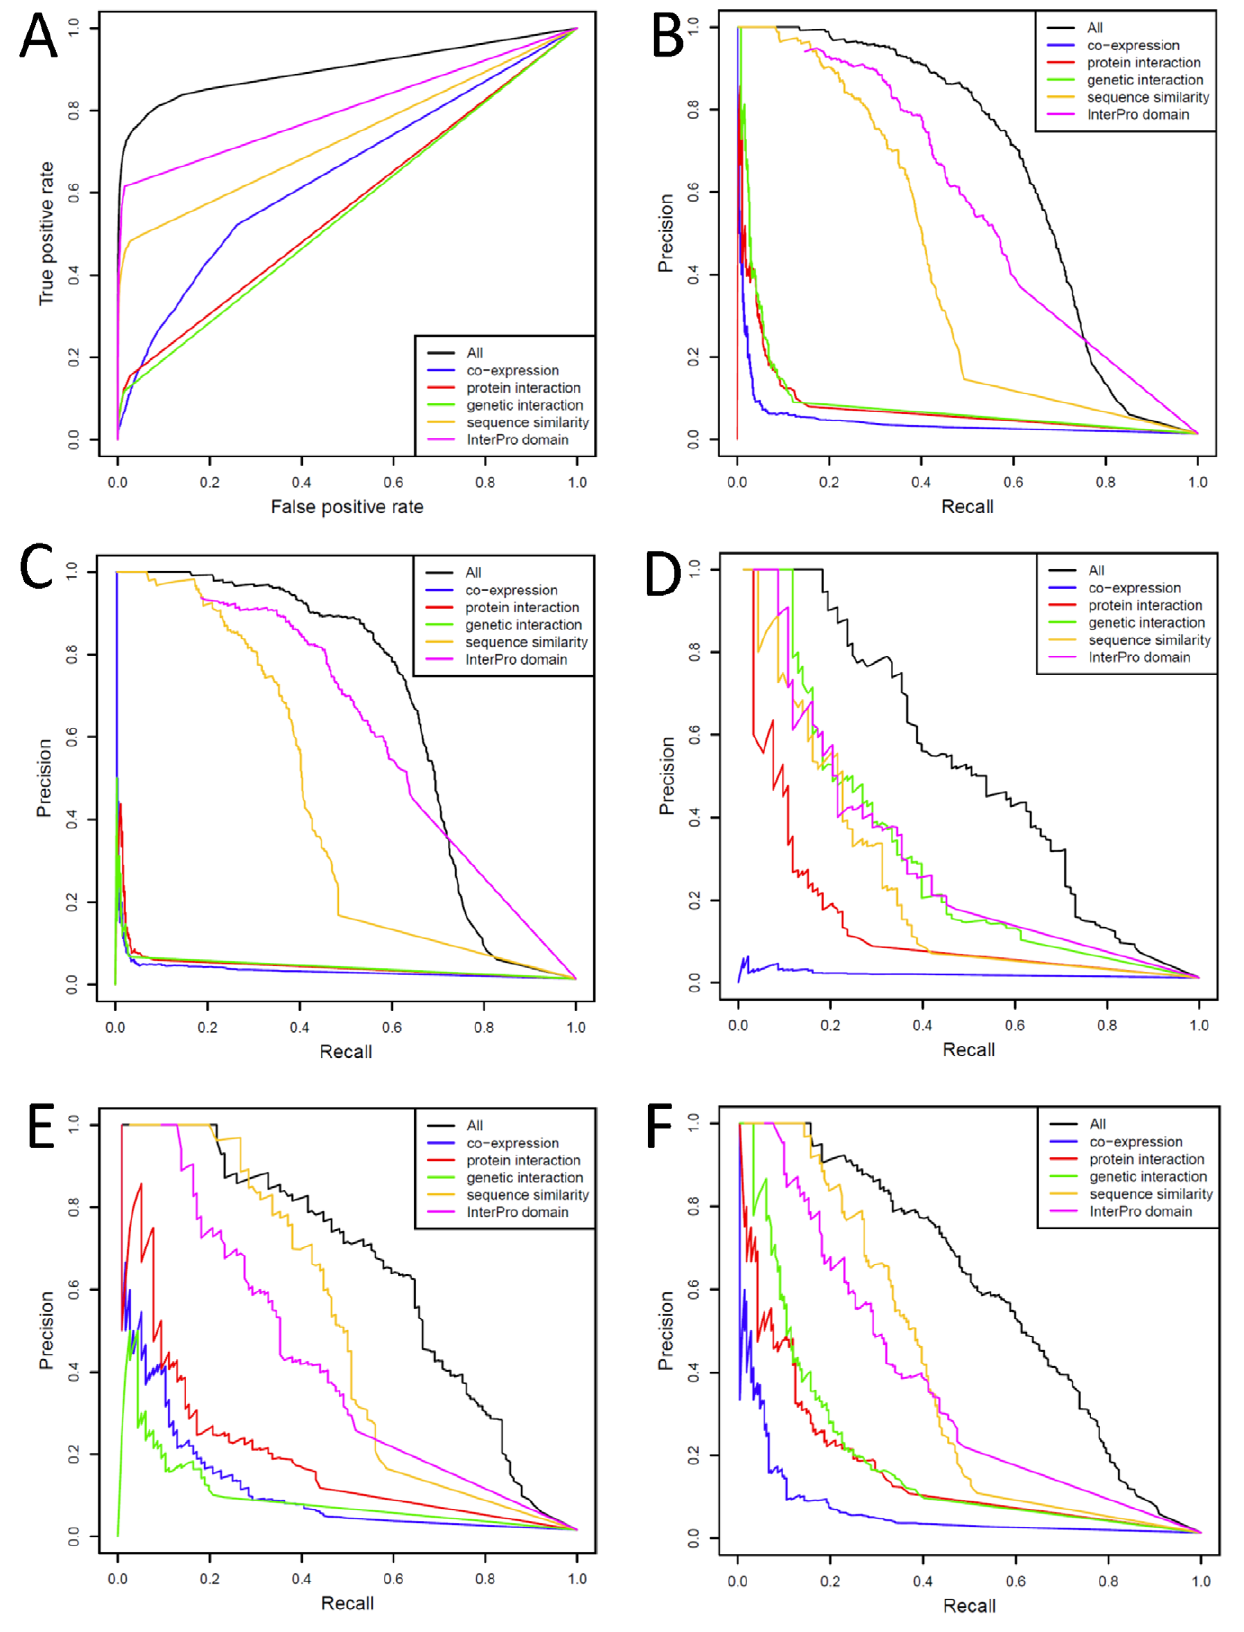
Figure 3. Performance of the KEGG pathway prediction model. Receiver Operating Characteristic curves ( A ) and Precision-Recall curves ( B ) for the overall performance and contribution of each feature in the KEGG pathway prediction. Precision-Recall curves for the performance of the model in predicting metabolism only ( C ), signaling pathway only ( D ), basic functions ( E ), and all non-metabolism functions ( F ).